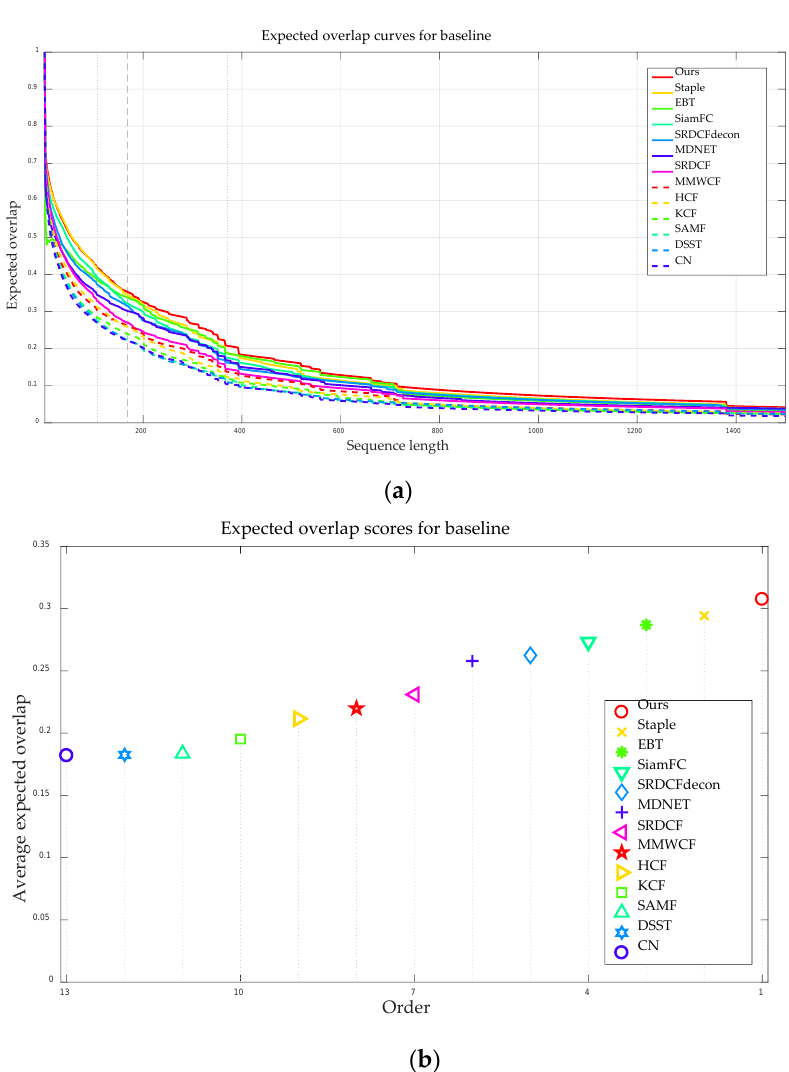
Figure 11. Comparison of the expected average overlap (EAO) for different trackers. ( a ) Ranking results of EAO, where the better trackers are located at the top and right. ( b ) EAO curves of trackers over different sequences lengths. Table 3. The EAO performance comparison of ours and seven other state-of-the-art trackers on the VOT2016 dataset. The best two results are marked in red and blue bold fonts.